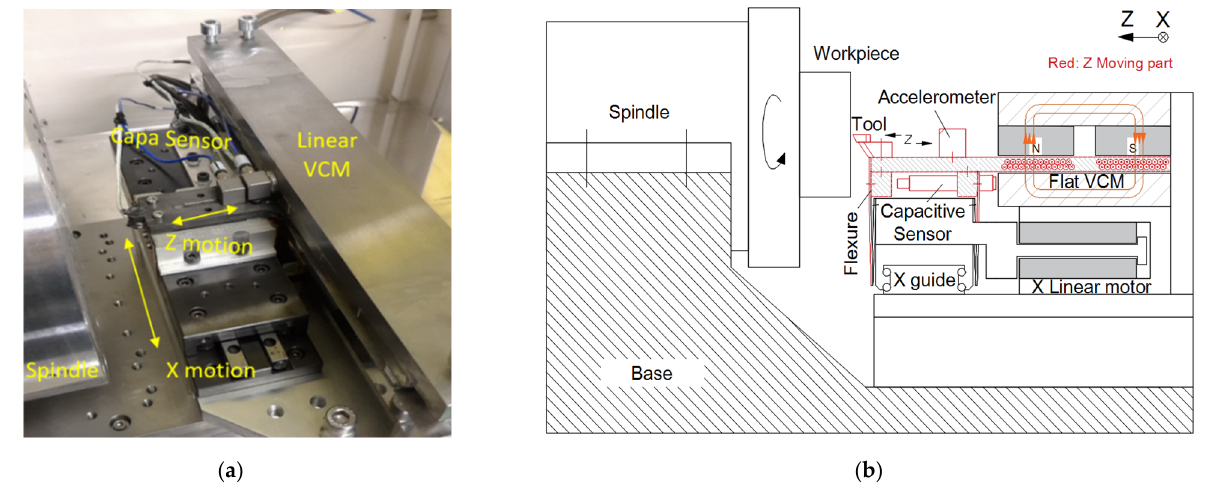
Figure 1. ( a ) Photo and ( b ) structural diagram of the fast-actuation cutting system.